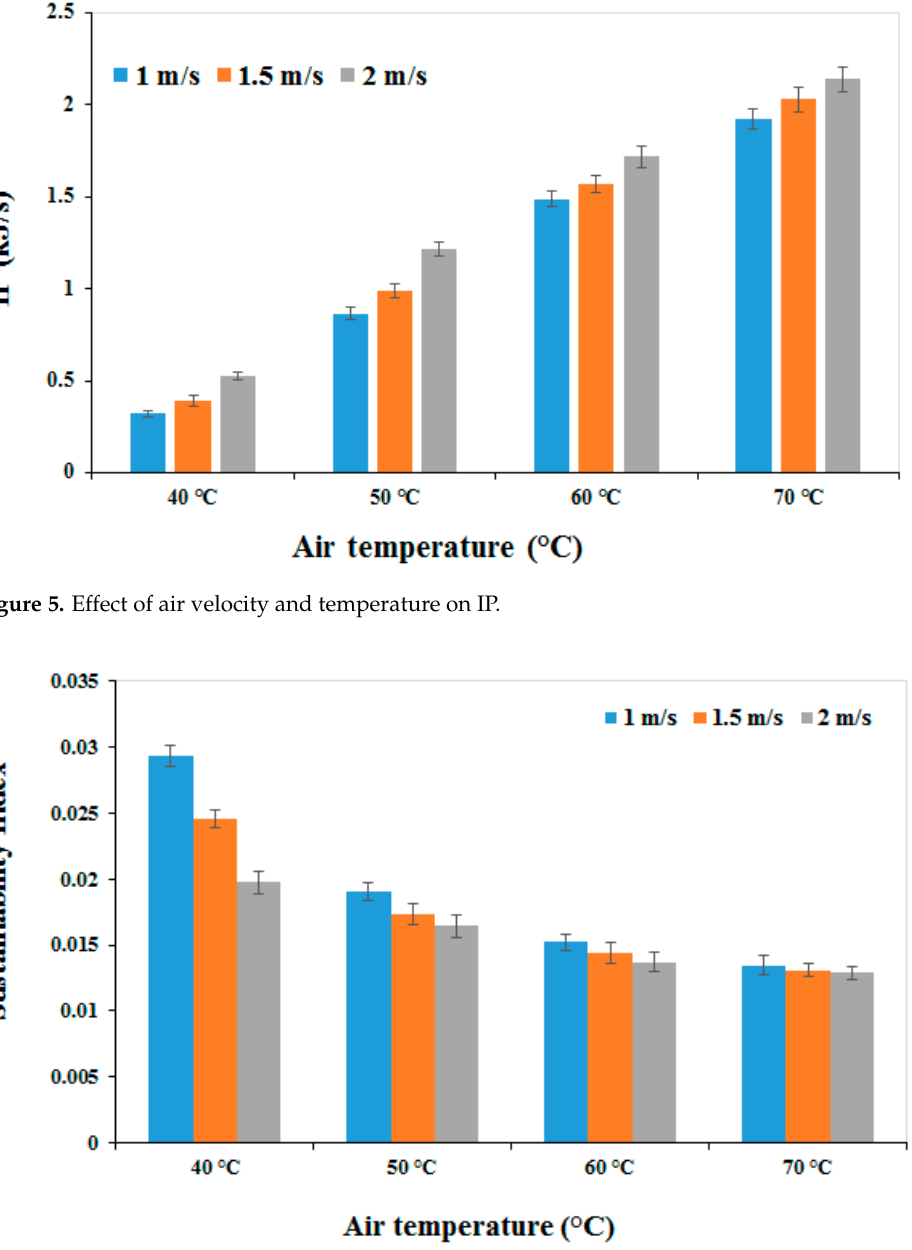
Figure 6. Effect of air temperature and air velocity on SI.